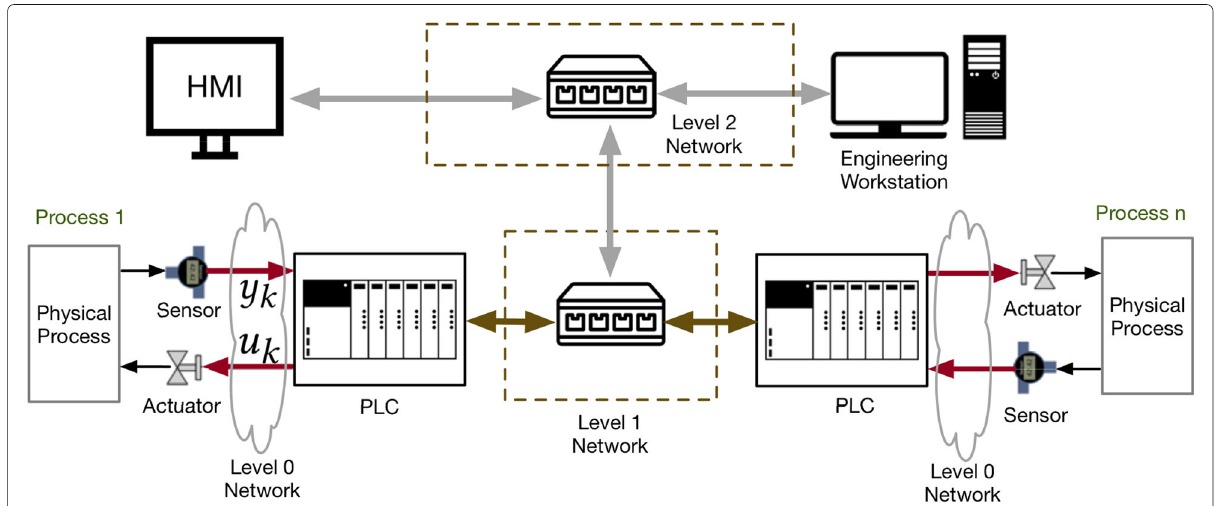
Fig. 1 An abstract view of an Industrial Control System